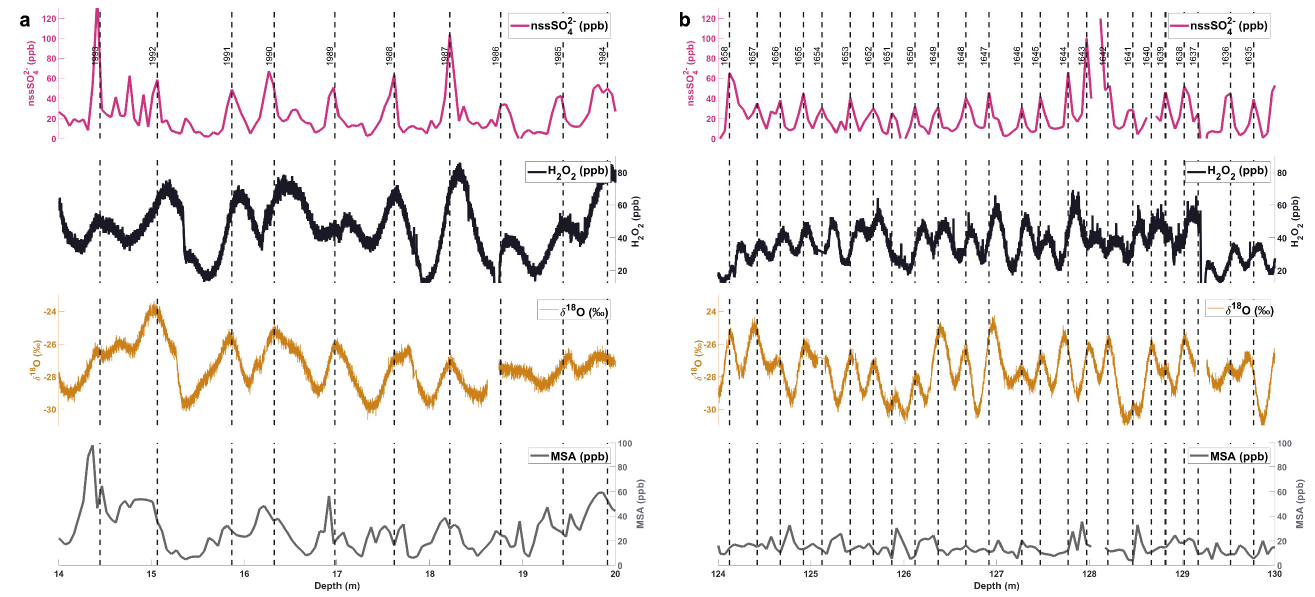
Figure 2. Example intervals of chemical signals in the Palmer ice core. Non-sea-salt sulfate [[nssSO 42 − ], magenta line (ppb)], hydrogen peroxide [H 2 O 2 , black line], δ 18 O [yellow line, (‰)], and MSA [grey line, (ppb)] plotted against depth (measured from the snow surface) ( a ) 14–20 m, ( b ) 124–130 m. Annual-layer markers are indicated by dashed vertical lines.